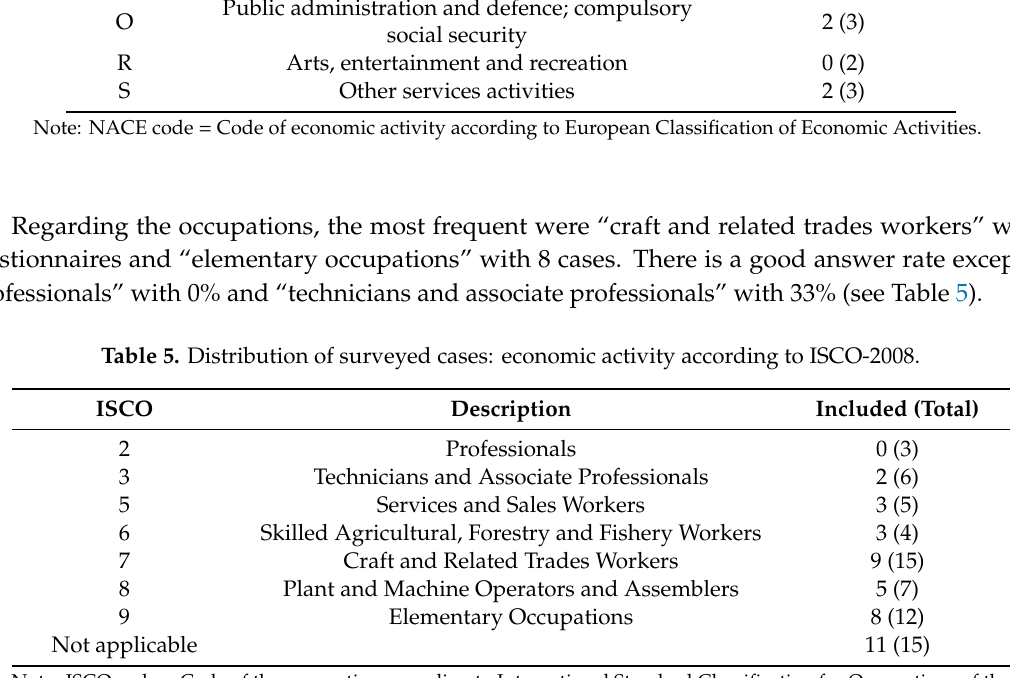
Table 4. Distribution of surveyed cases: economic activity according to NACE-2009. NACE Description Included (Total) C Manufacturing 12 (14) Water supply; sewerage; waste management and E remediation activities F Construction 2 (3) Wholesale and retail trade; repair of motor vehicles G and motorcycles H Transporting and storage 0 (2) I Accommodation and food service activities 1 (6) N Administrative and support service activities 7 (9) Public administration and defence; compulsory O social security Arts, entertainment and recreation